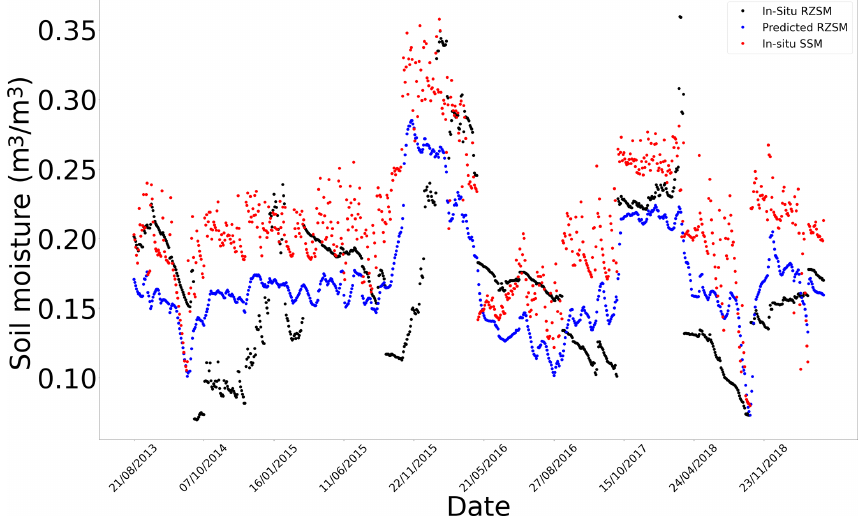
Figure E11. In situ SSM, in situ RZSM, and predicted RZSM series at station 2.04 (HOBE) with model ANN_SSM.